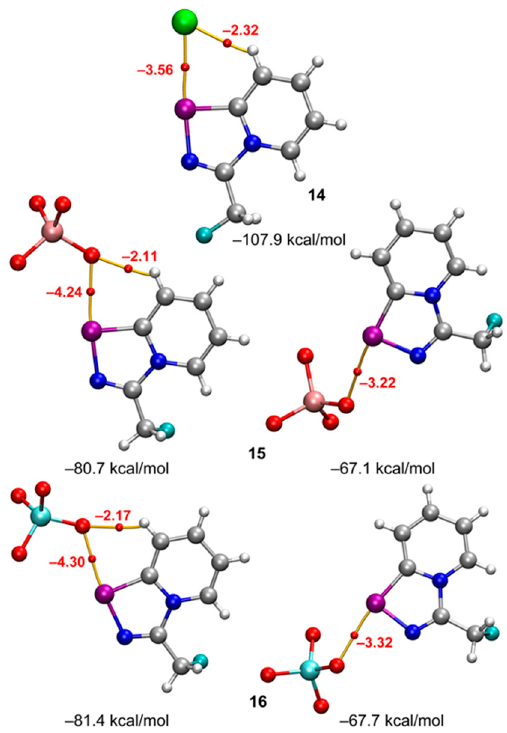
Figure 12. QTAIM analyses of compounds 14 – 17 . Only intermolecular bond CPs and bond paths are represented. The interaction energies of the ChB and HB contacts are indicated next to the bond CPs (small red spheres) in kcal/mol.